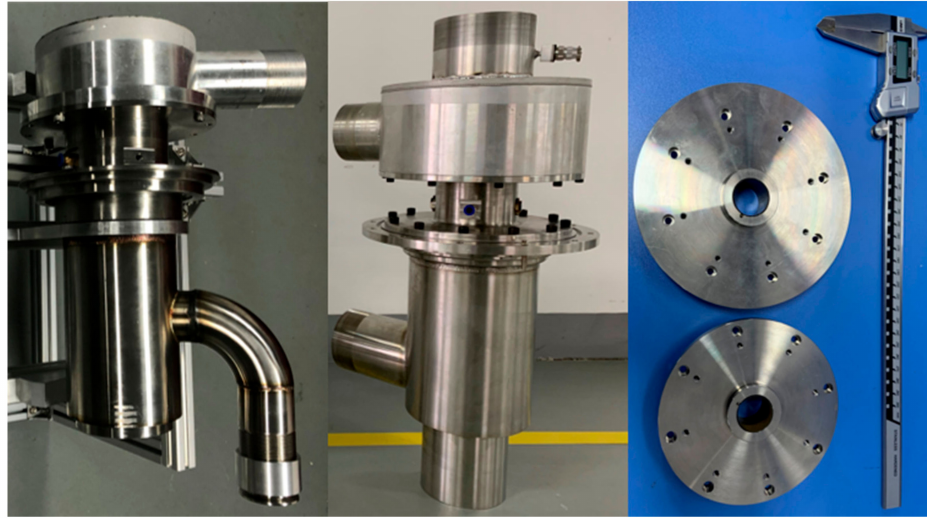
Figure 3. Helium turbo-expander and hydrogen turbo-expander by Xi’an Jiaotong University.